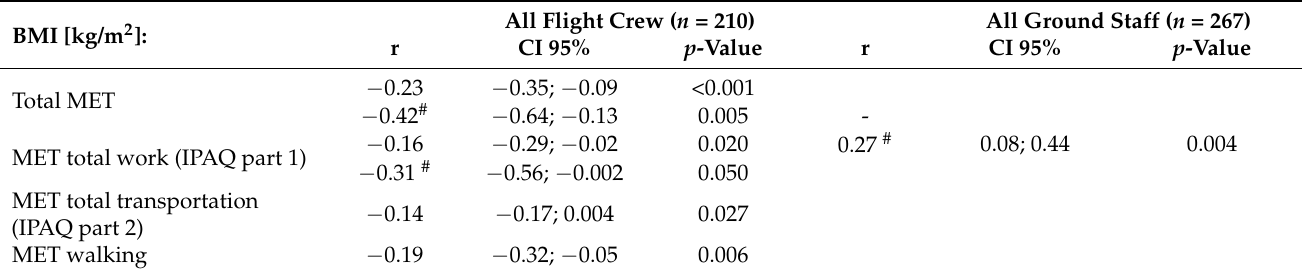
Table 4. Correlation of BMI with other variables related to